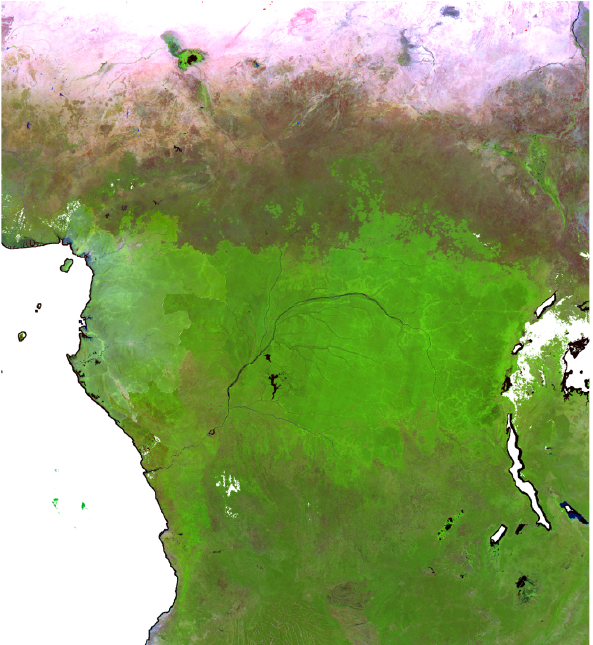
Fig. 2. The consistent image obtained by combining different composites for each zone; in the north a seasonal composite for December–January corresponding to the dry season in the northern part (MIR SPOT VGT, NIR and Red from Meris), in the south a seasonal composite for May–June corresponding to the dry season in the southern part (MIR SPOT VGT, NIR and Red from Meris), for the centre (DRC, Congo and RCA) an annual composite (MIR SPOT VGT, NIR and Red from Meris) and an exclusively SPOT VGT composite for the centre (Equatorial Guinea, Cameroon an